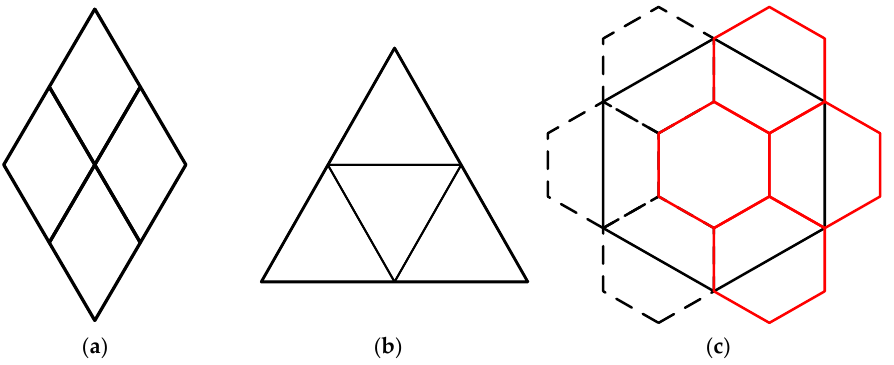
Figure 1. The first level hexagonal and pentagonal cells on the icosahedron.